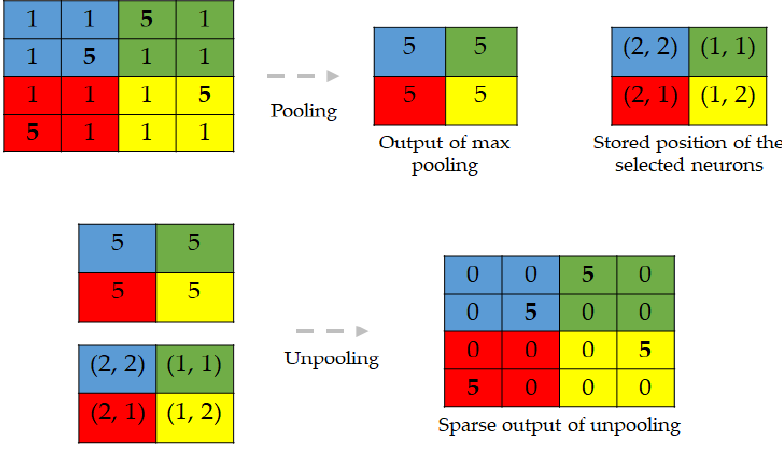
Figure 10. Illustration of pooling with “position storage” and unpooling.